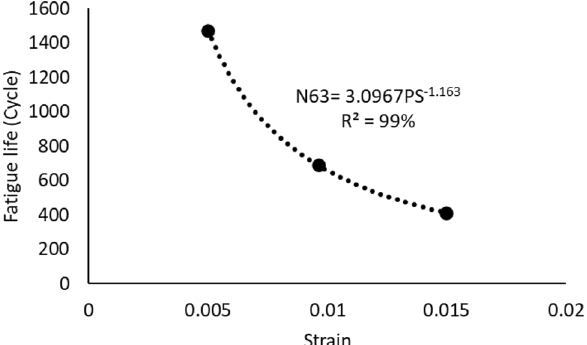
Figure 15. The Coffin Manson model of SAC305 solder that are cycled at room temperature and different stress